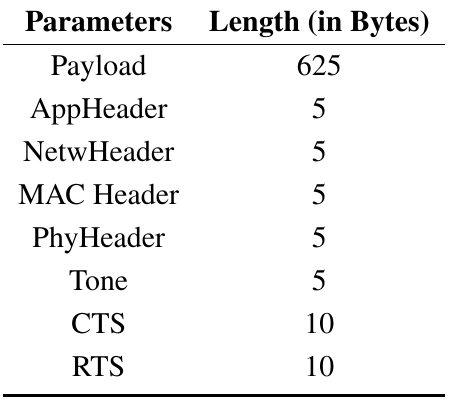
Table 1. Protocol parameters. CTS, clear to send; RTS, request to send.